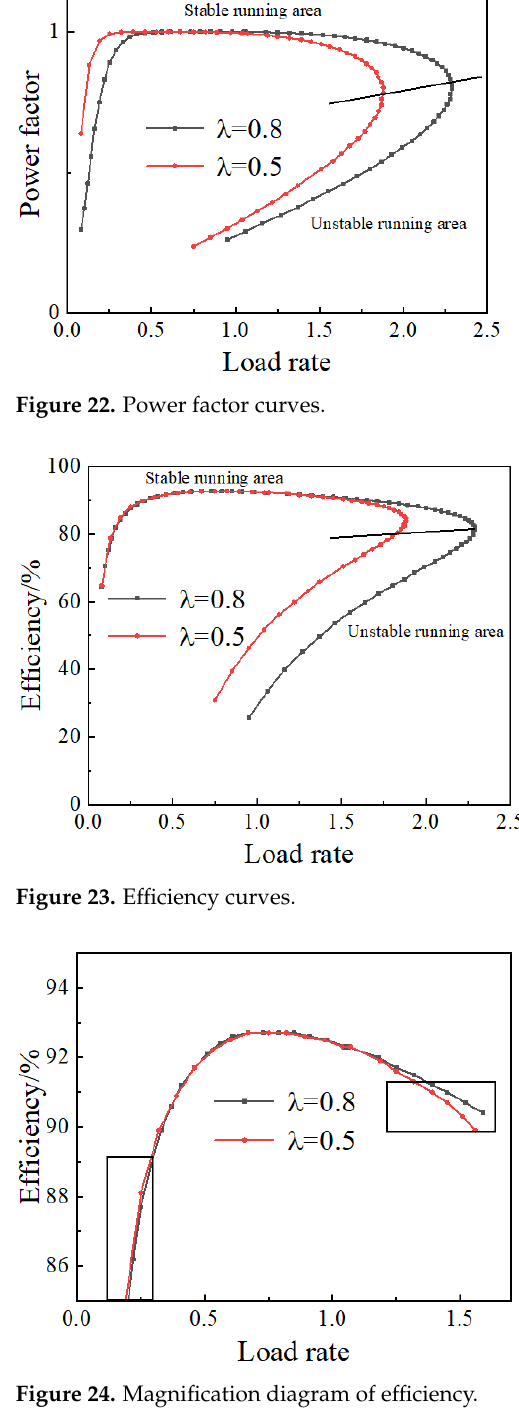
Table 1. Main parameters of the prototype.